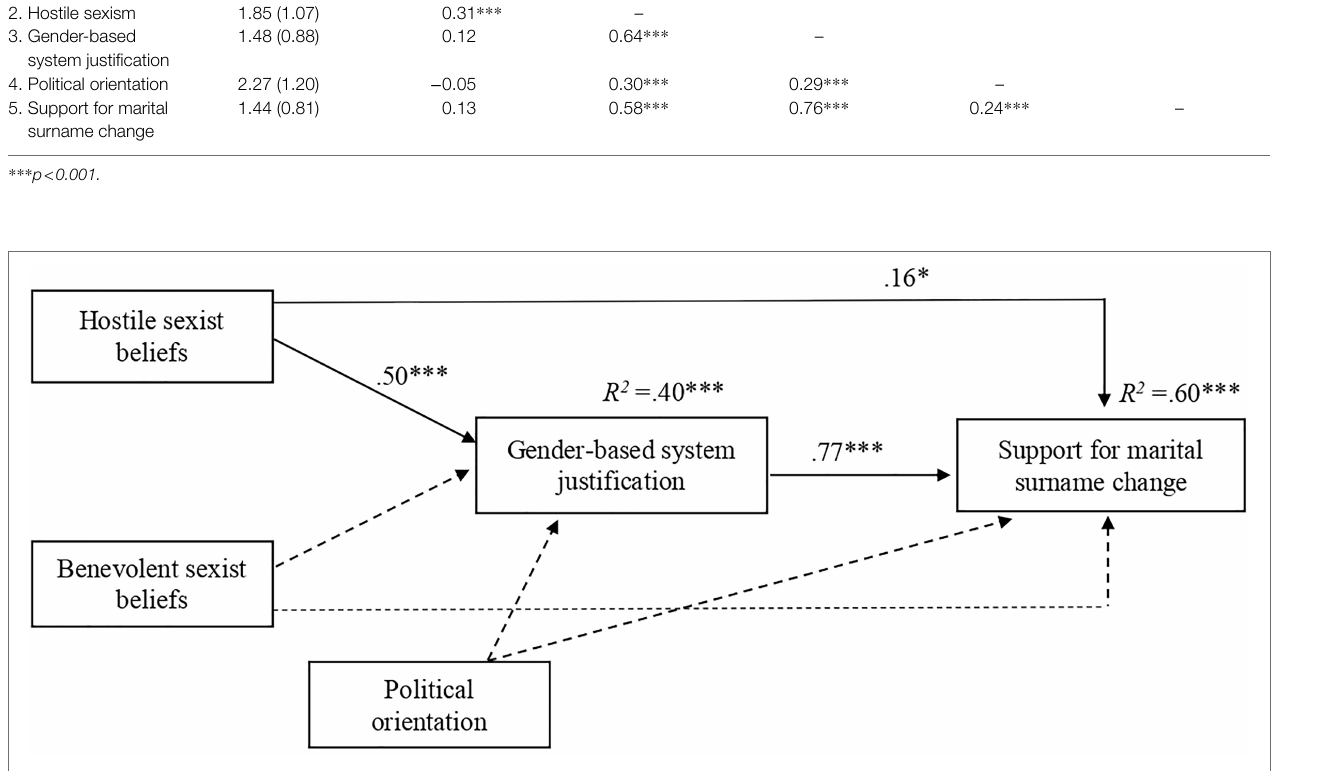
FIGURE 2 | The results of mediation analysis in Study 1. Standardized regression coefficients for the relationship between hostile and benevolent sexism (IVs) and support for marital surname change (DV) as mediated by gender-based system justification and controlled for political orientation, *** p < 0.001, * p < 0.05. Non-significant paths are shown as broken